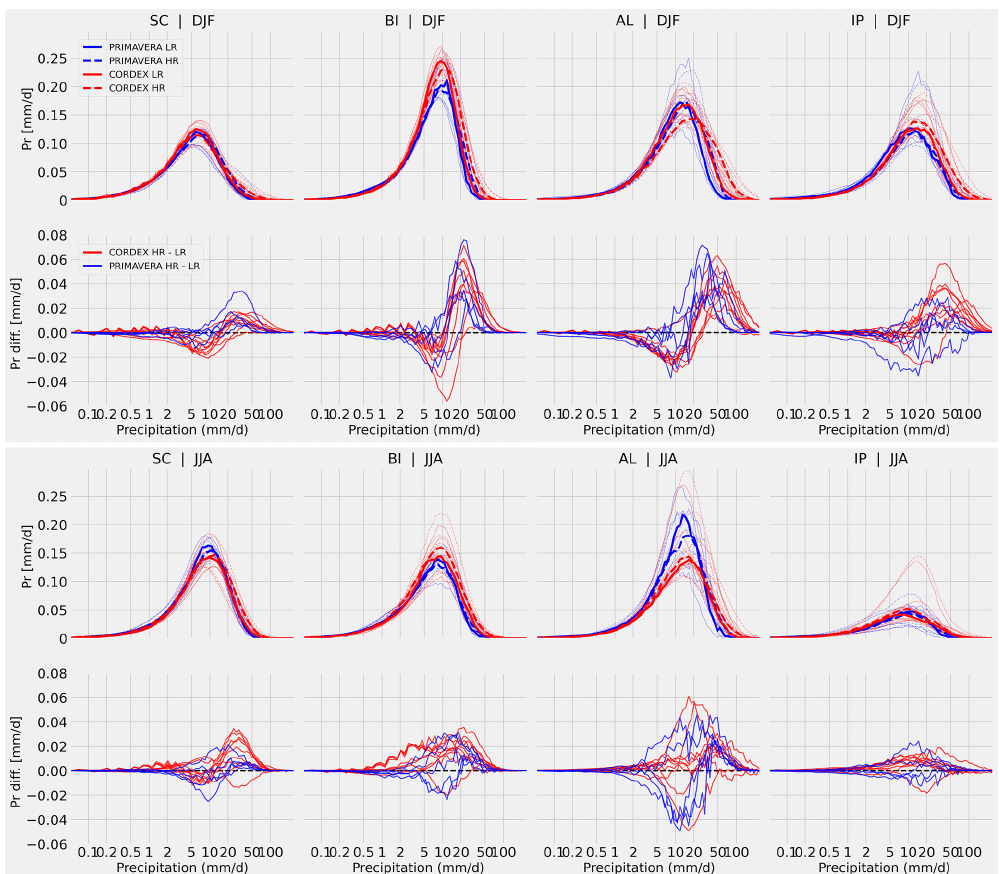
Figure 5. The panels show the actual contribution (to the total mean precipitation, y axis) per precipitation intensity bin ( x axis), based on DJF (top row) and JJA (bottom row) daily mean precipitation values in CORDEX and PRIMAVERA models for the Scandinavian (SC), British Isles (BI), Alps (AL), and Iberian Peninsula (IP) regions. Thin lines in the upper part of each panel represent each individual model while the thick lines represent the ensemble means. In the lower part of each panel each line represents differences between respective high- and low-resolution model